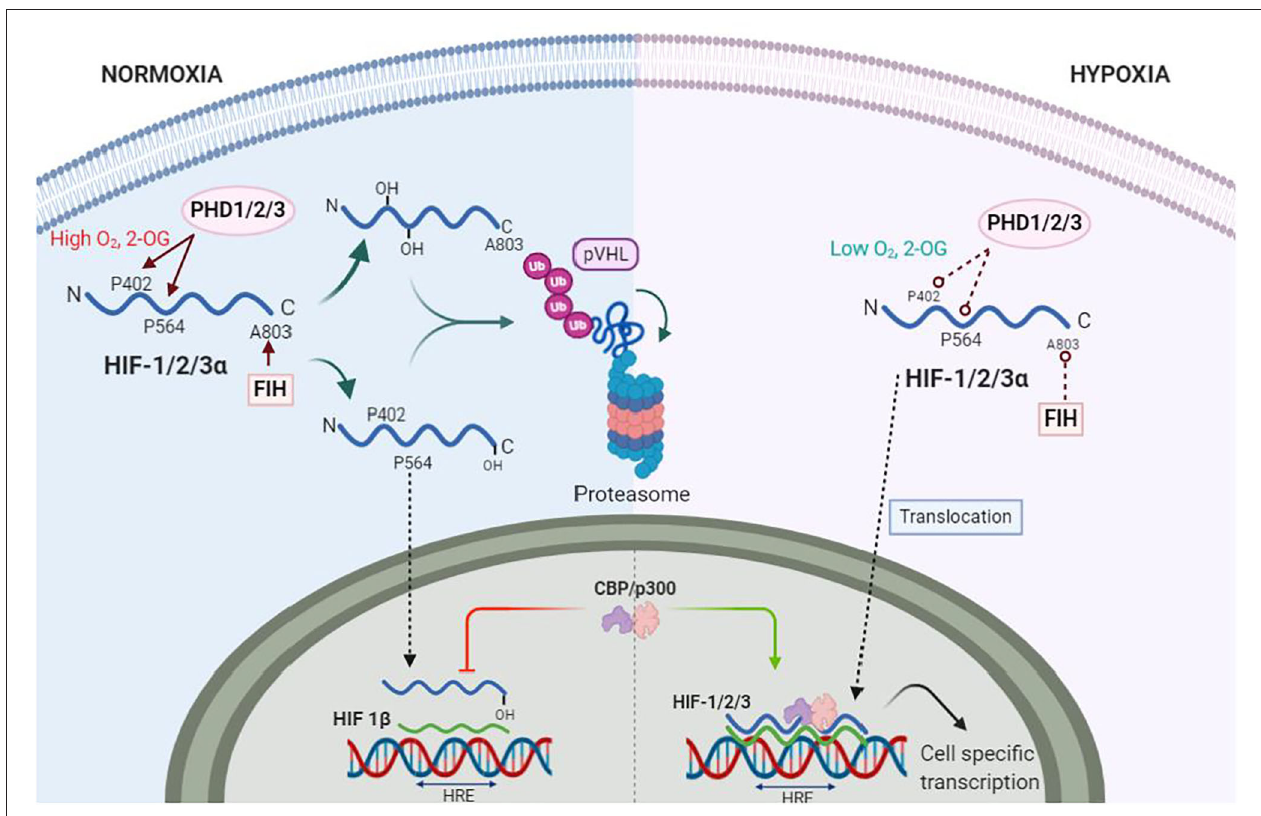
FIGURE 2 | Hypoxia Inducible Factors (HIFs) under normoxia and hypoxia. During normoxia proline residues 402 and 564 (P402, P564) of HIF- α (blue wave) are hydroxylated by prolyl-hydroxylase 1 and 2 (PHD1, PHD2), whereas PHD3 hydroxylates only P564. The factor inhibitor of HIF (FIH) hydroxylates asparagine residue A803, which inhibits binding of nuclear protein CREB (CREB) and p300s. PHDs and FIH are dependent on oxygen (O 2 ) and 2-Oxoglutarate (2-OG) concentrations. Hydroxylated HIF-1 α is ubiquitinated by von Hippel Landau (VHL) ubiquitin ligase complex for proteasomal degradation. Under hypoxia, PHDs and FIH become inactive, allowing HIF- α stabilization and translocation to the nuclei. Here, HIF- α dimerizes with HIF-1 β (green wave). The dimer is then termed HIF-1/2/3 and binds to the hypoxia response elements (HRE) of specific genes in the DNA to transcribe thousands of